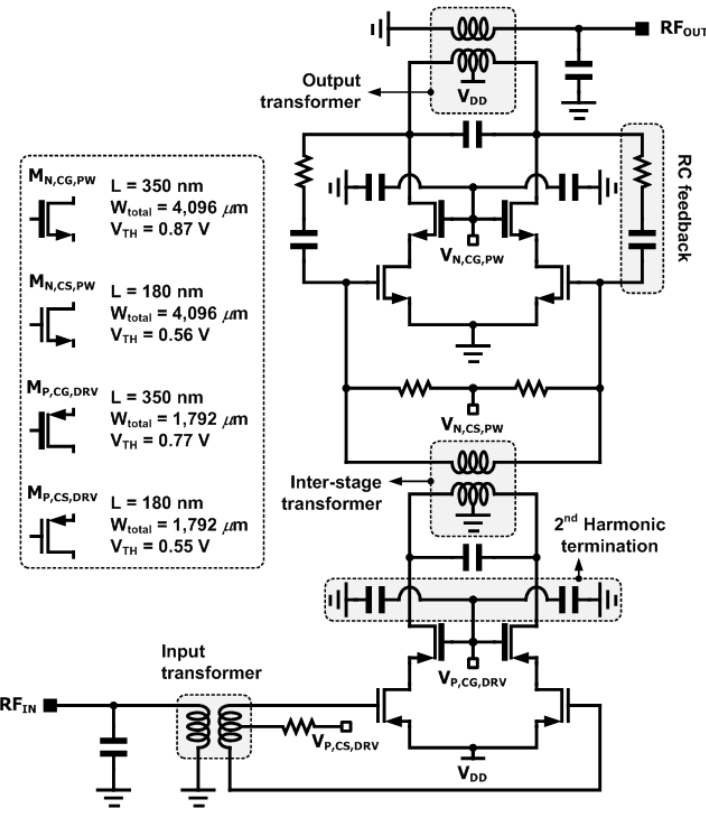
Figure 14. Schematic of proposed complementary metal-oxide semiconductor (CMOS) PA (V DD = 3.3 V).